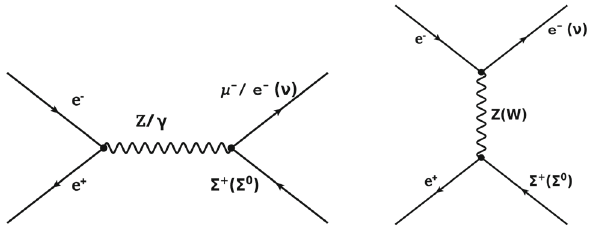
Fig. 1 Feynman diagrams contributing to the process e + e − → (cid:2) + (cid:4) − ((cid:2) 0 ν ). Note that (cid:2) 0 ν production does not have a photon medi- ated s -channel